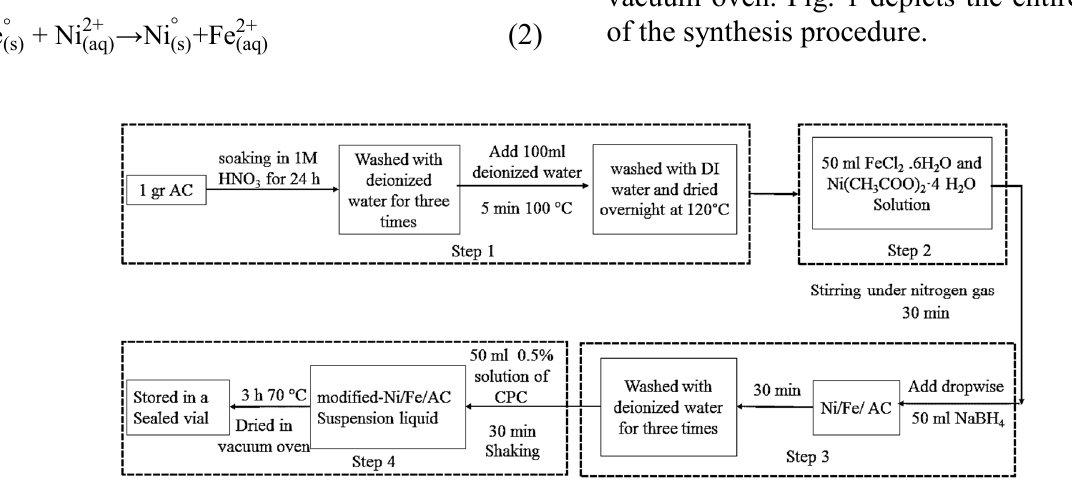
Fig. 1. Schematic illustration of the preparation of Ni/Fe nanoparticleson AC (The whole procedure was bubbled with N 2